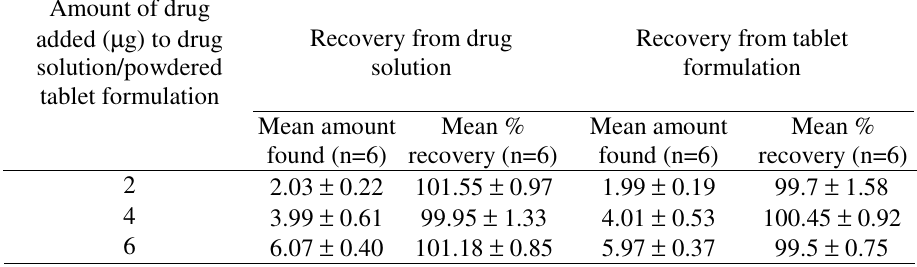
Table 3. Experimental values obtained in the recovery test for RBP tablets by proposed method